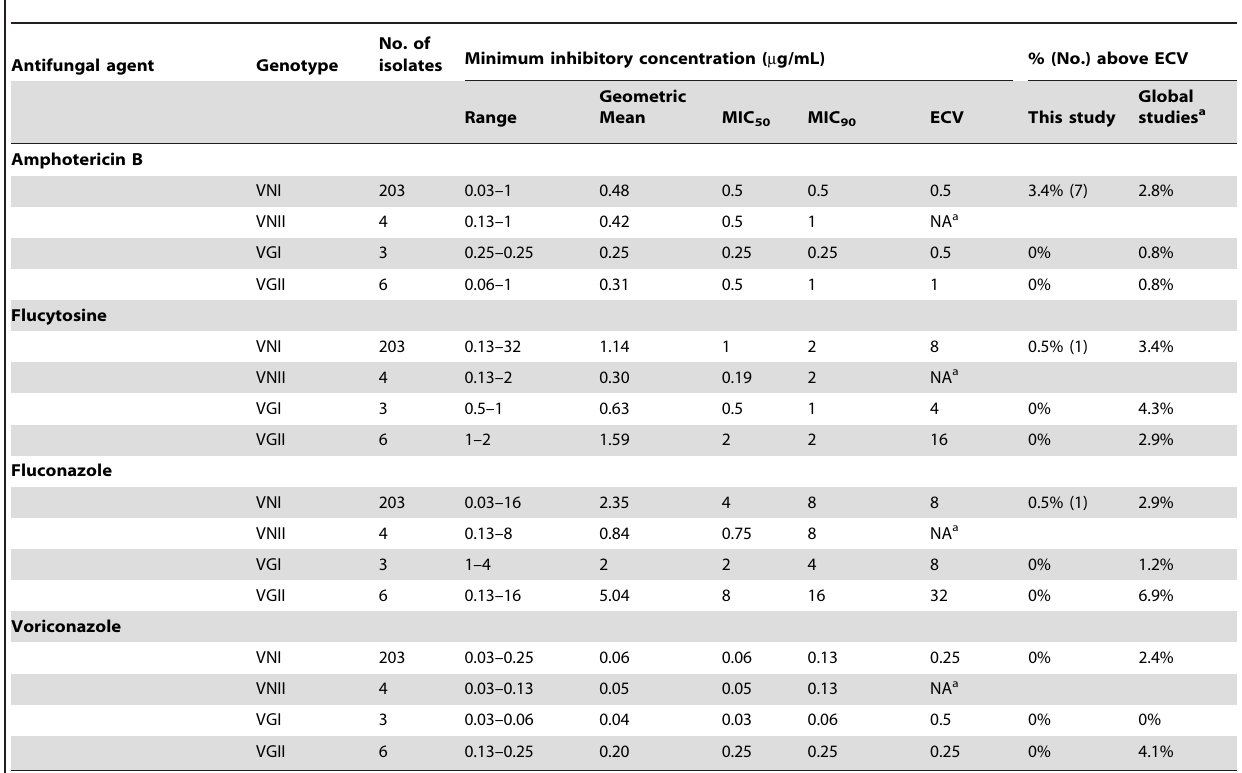
Table 1. Susceptibility of 216 cryptococcal clinical isolates to four antifungal agents in Taiwan, 1997–2010.